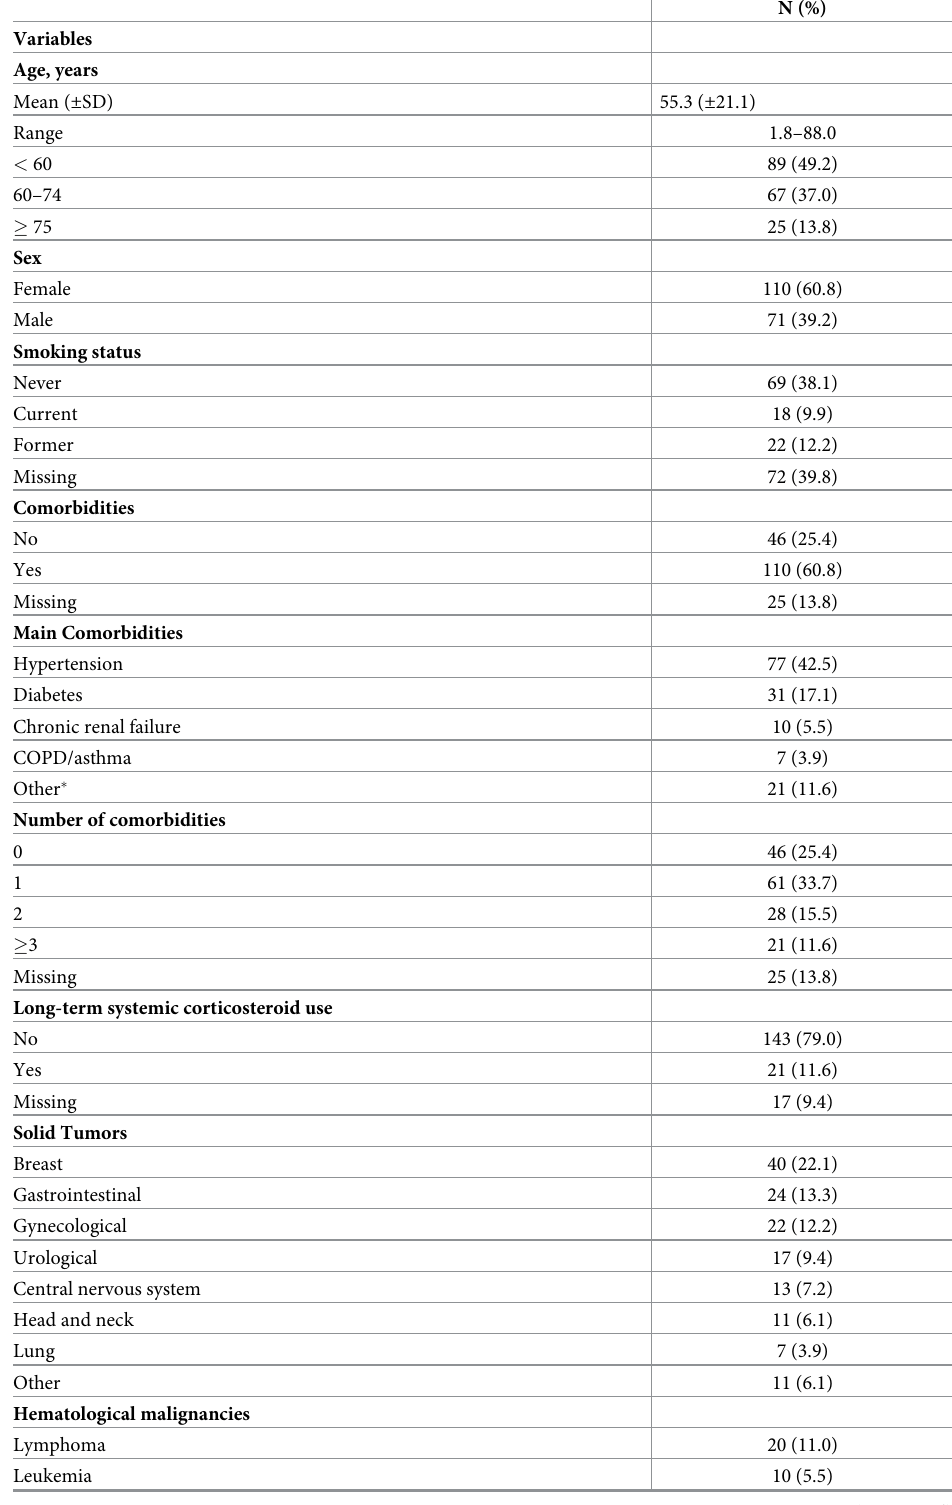
Table 1. Baseline demographic and clinical characteristics of the